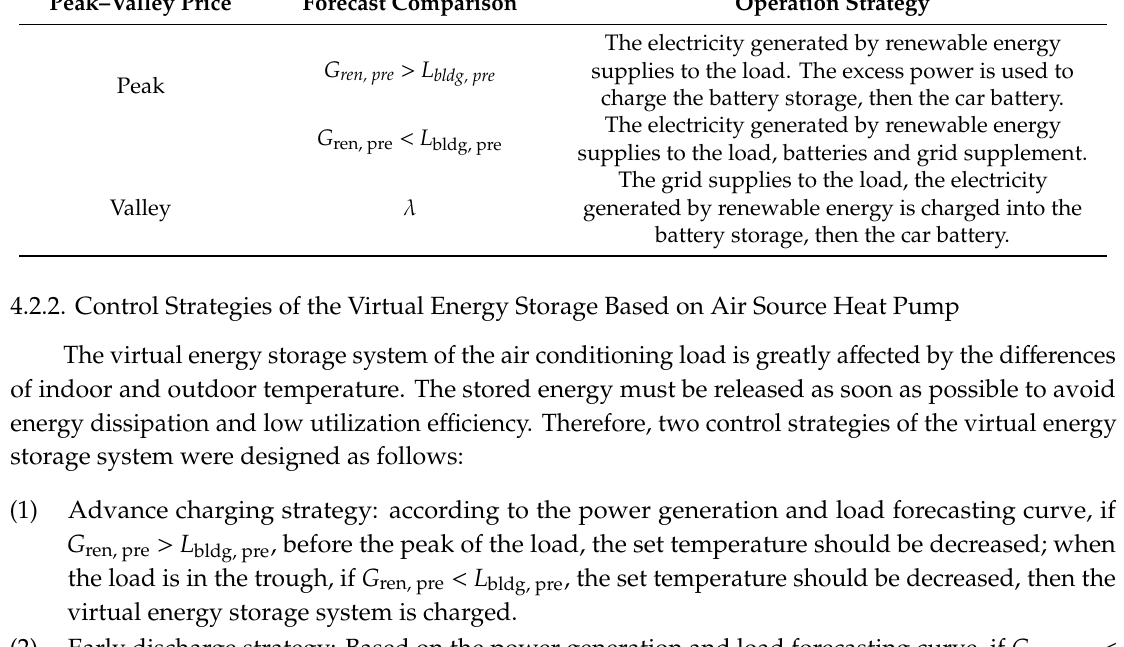
Table 3. Specific control strategy of building energy system of the renewable energy system. Peak–Valley Price Forecast Comparison Operation Strategy